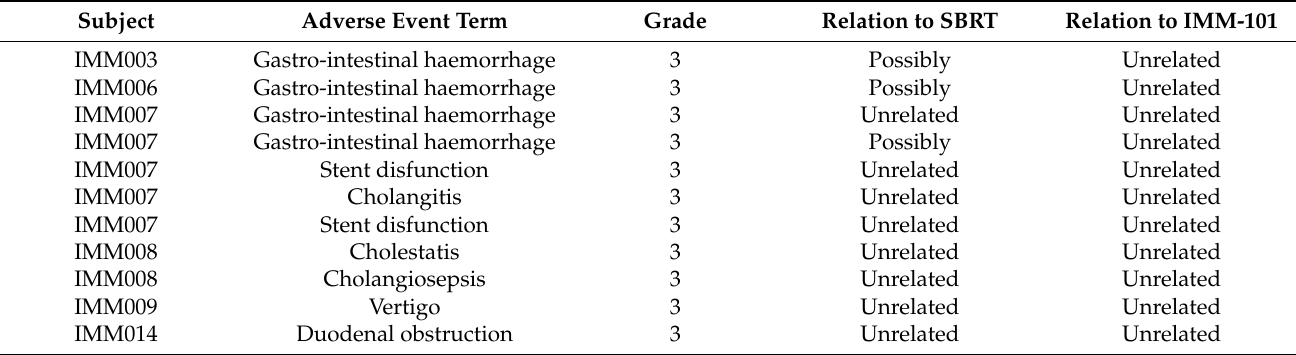
Table 2. Grade 3 or higher adverse